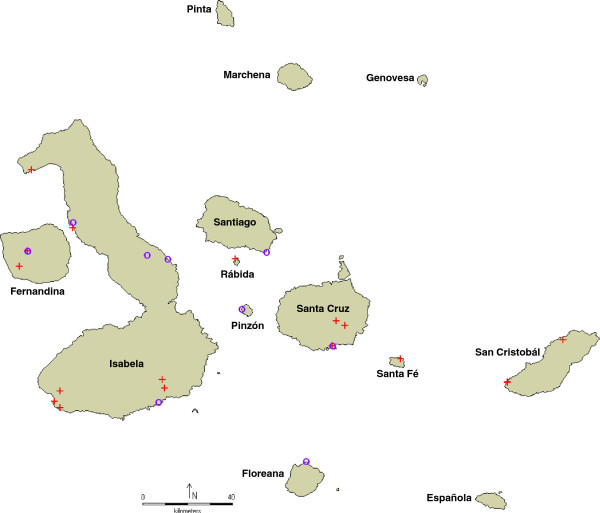
Geographical distribution of the tomato accession on the Galapagos Islands.Solanum galapagense S.C. Darwin & Peralta (violet circle symbol); S. cheesmaniae L. Riley (red plus sign symbol). Map made with DIVA-GIS version 7.5 [44].